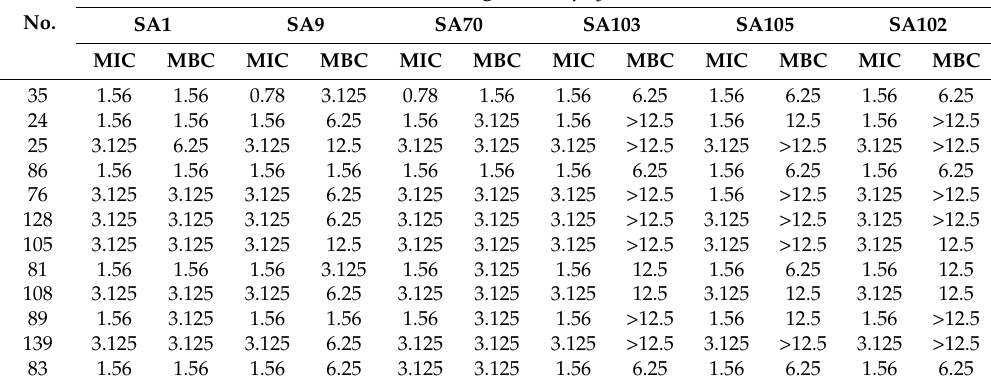
Table 2. Antibacterial activity of the most active Polish honeys against S. aureus isolates from